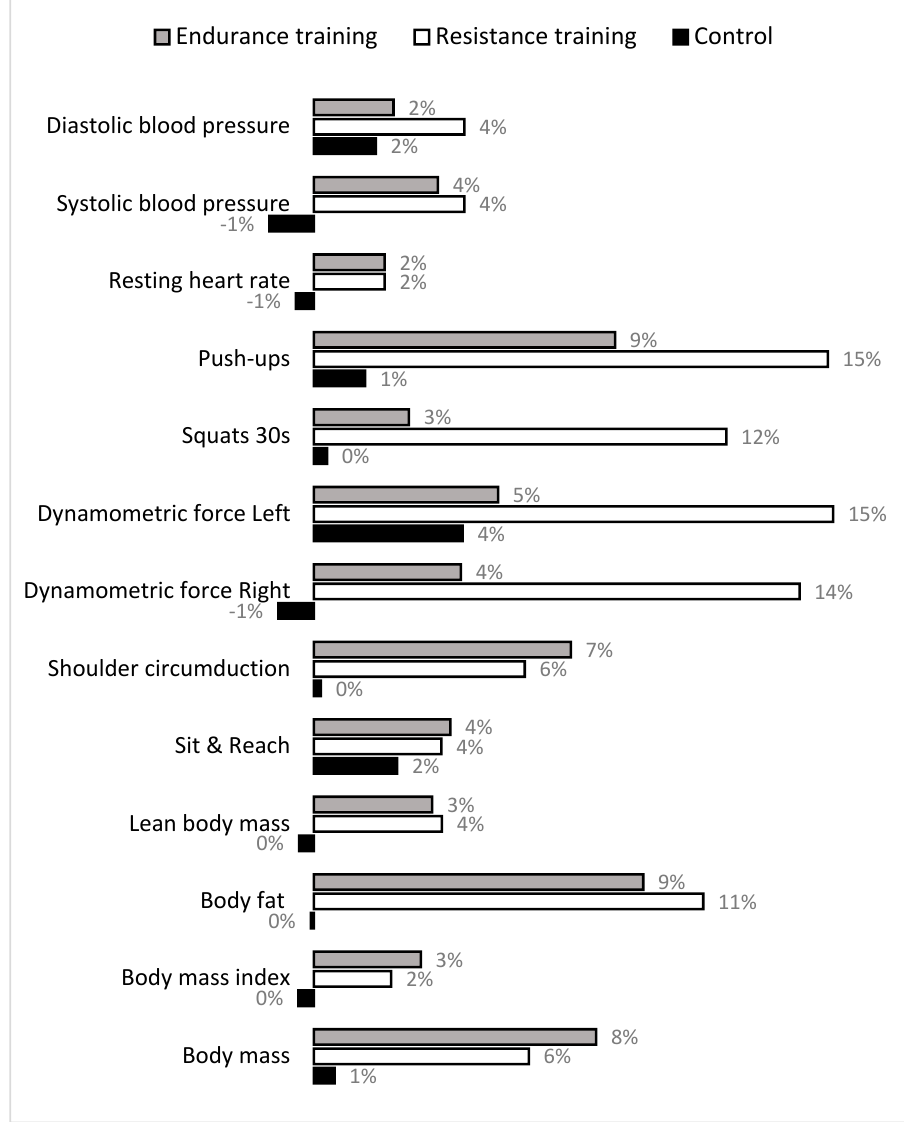
Figure 2. Percentage differences (improvements) in observed variables between pre- and post- measurement.